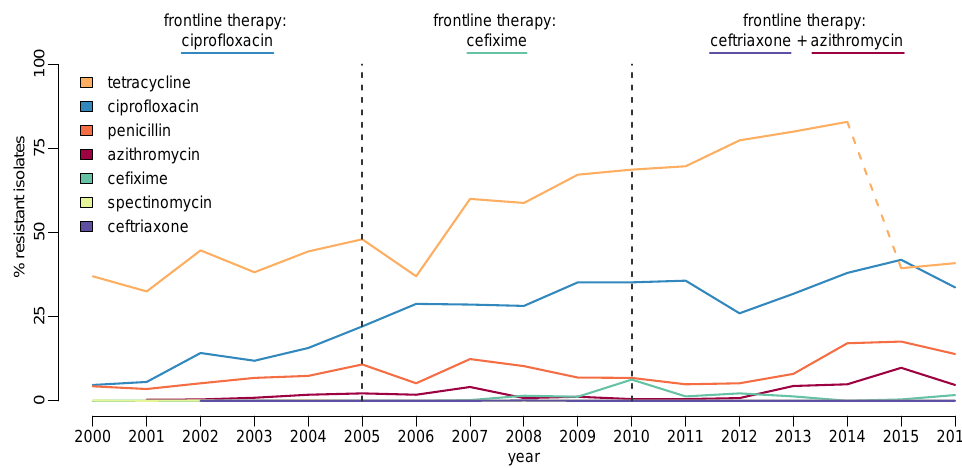
Figure 3. Proportion of gonococcal isolates in Gonococcal Resistance to Antimicrobials Surveillance Programme (GRASP) showing resistance to different antibiotics over time. Dashed vertical lines show dates of treatment guideline change. In 2015, the GRASP agar medium used to determine MIC values changed, so results after this date are not comparable to previous years, particularly for azithromycin and tetracycline. The azithromycin resistance levels for 2013 and 2014 have been adjusted upwards from those published by GRASP, as previously suggested [54], but on the other hand, the tetracycline levels are not directly comparable before and after 2015, as highlighted by the dashed